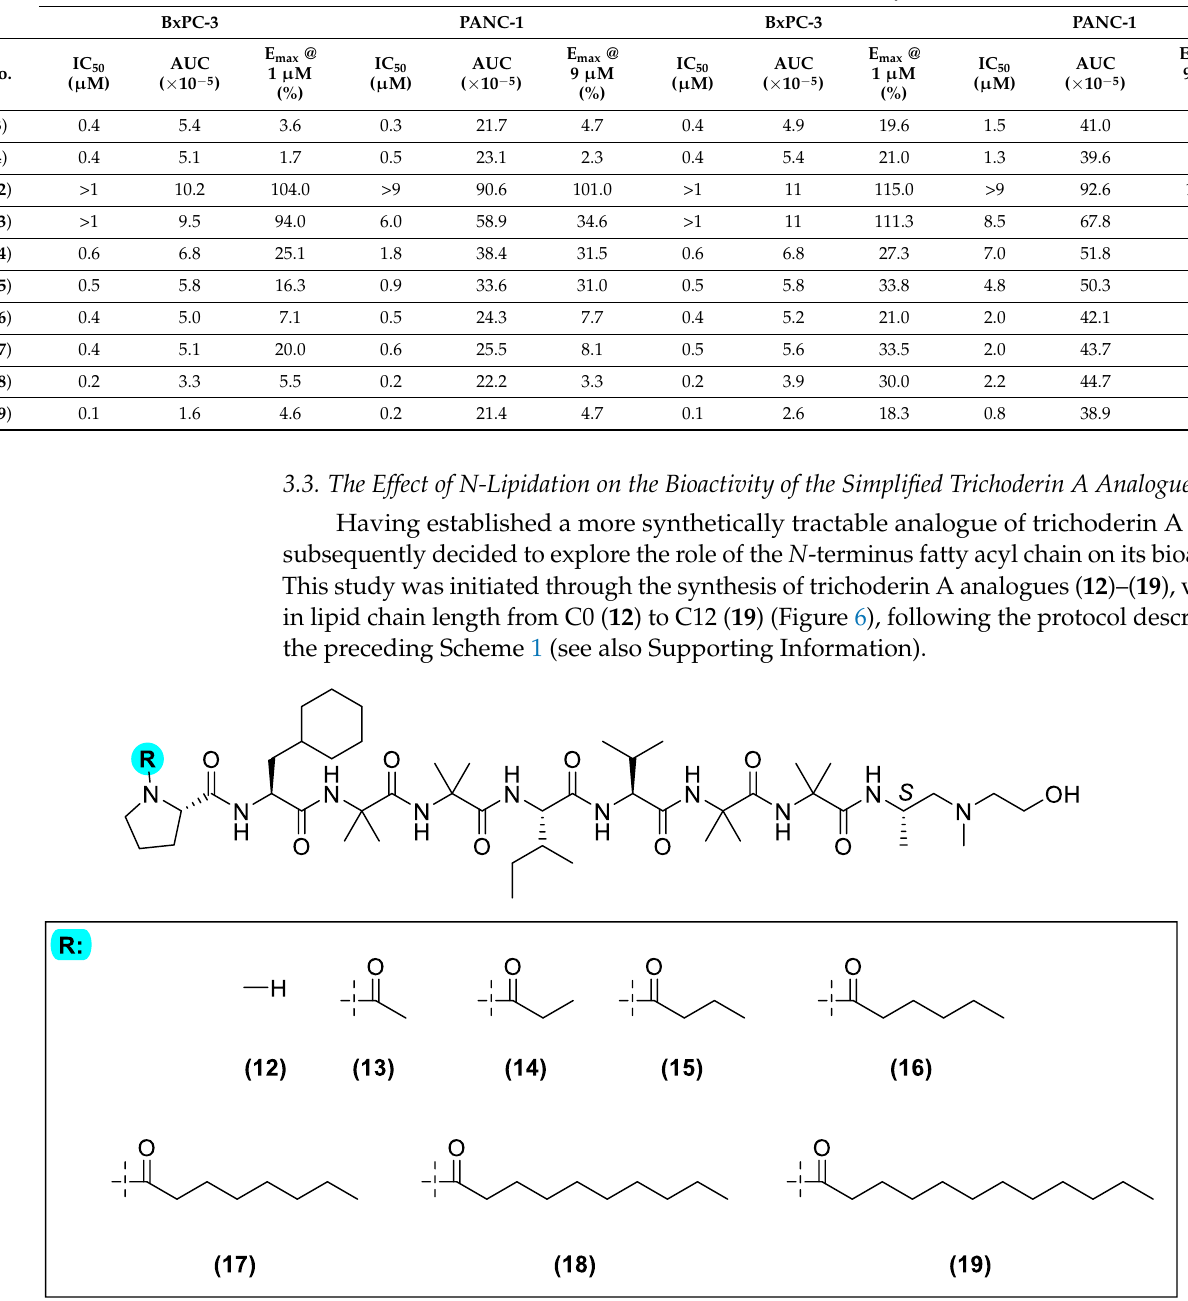
Figure 6. General structure of the simplified trichoderin A analogue ( 4 ). The N-terminus has been modified accordingly to generate analogues ( 12 ) – ( 19 ).